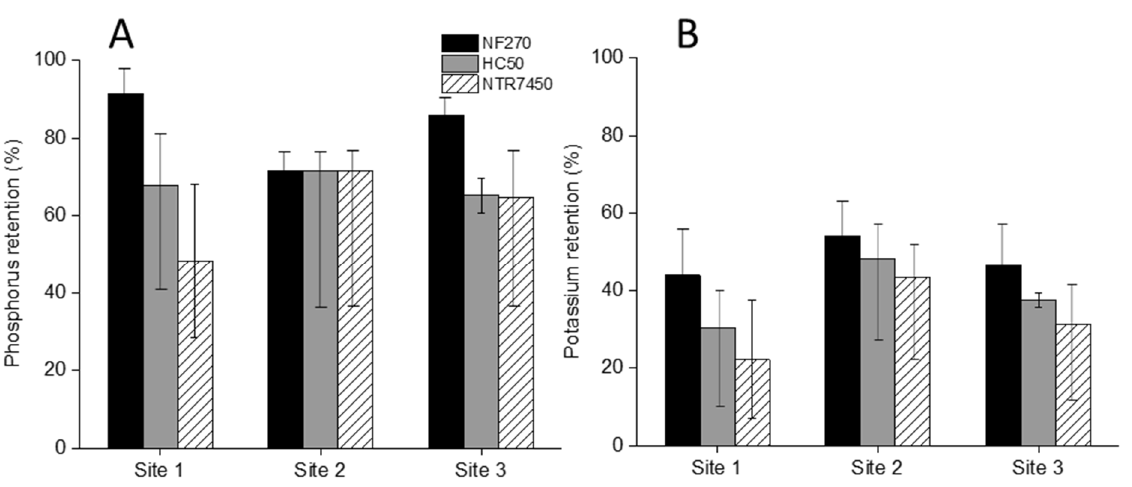
Figure 4. ( A ) Phosphorus and ( B ) potassium retention of MF permeate at 50% recovery by NF270, HC50, and NTR7450 membranes from all sampling sites. Pressure: 6.5 bar; stirring rate: 400 rpm; temperature: 25 °C.